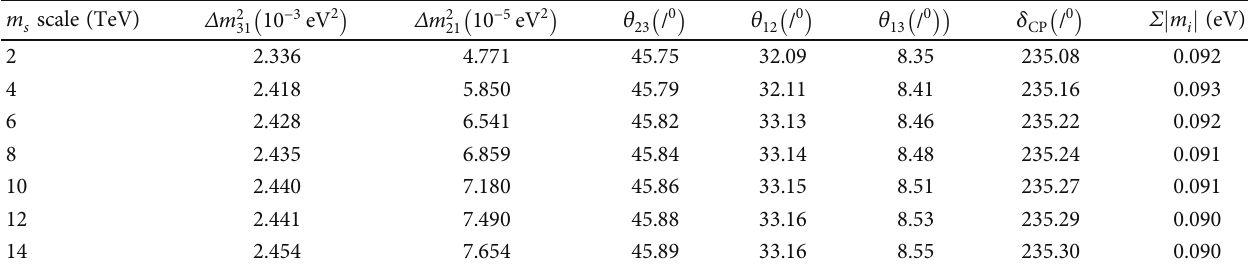
for NH case ð tan β = 40, M s